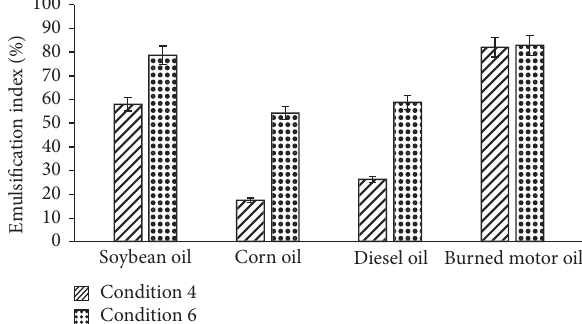
Figure 1: Emulsification index of bioemulsifier produced by Stenotrophomonas maltophilia UCP 1601 in conditions 4 and 6 of the 2 4 FFD, using different hydrophobic